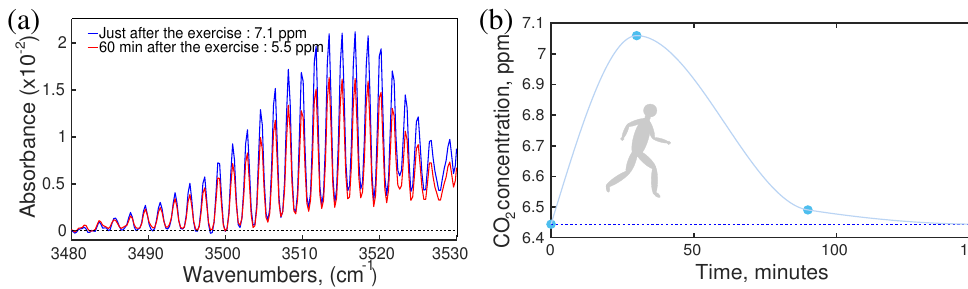
Figure 2. The effect of physical exercise. ( a ) Absorption spectra of breath CO 2 . ( b ) The dynamics of CO 2 concentration during and after jogging. (Ref.[17]).